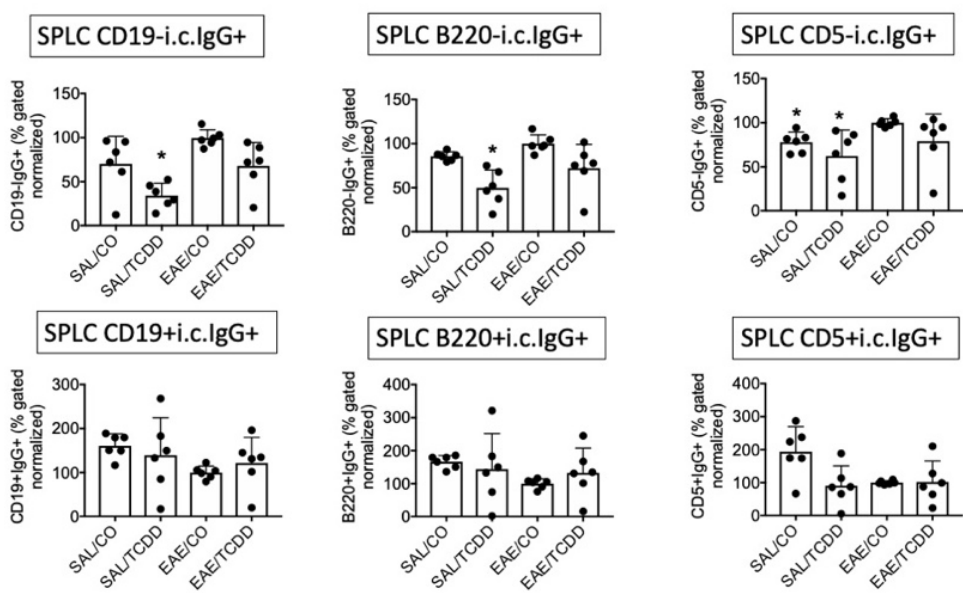
Figure 1. TCDD modestly suppressed i.c. IgG in SPLC in EAE. EAE was induced in mice using active immunization with MOG peptide on day 0. TCDD (2.5 µg/kg/day) in corn oil (CO) was administered via oral gavage for 12 days for a cumulative dosage of 30 µg/kg. At day 18, mice were sacrificed and SPLC were stained for extracellular B cell markers and i.c. IgG. Positive or negative B cell markers plus i.c. IgG double positive percentages were normalized in each of two experiments to the average of the EAE/CO groups ( n = 3 per experiment) to which all other groups were compared in that experiment (total n = 6). Graphs represent average ± SD of normalized values from the two separate experiments. * p < 0.05 as compared to EAE/CO using Friedman’s ANOVA and Dunn’s post hoc test. i.c., intracellular; SPLC, splenocytes; SAL, saline. As a comparison, we show here that the B220-i.c. IgG+ and CD5-i.c. IgG+ populations are similarly affected by TCDD, although again, effects were modest. There were few differences in the percentage of i.c. IgG from B cells derived from LN or BM at end-stage disease, although there was a trend toward reversing the EAE-induced reduction in i.c. IgG on CD19+ and B220+ B cells in the BM (Figures 2 and